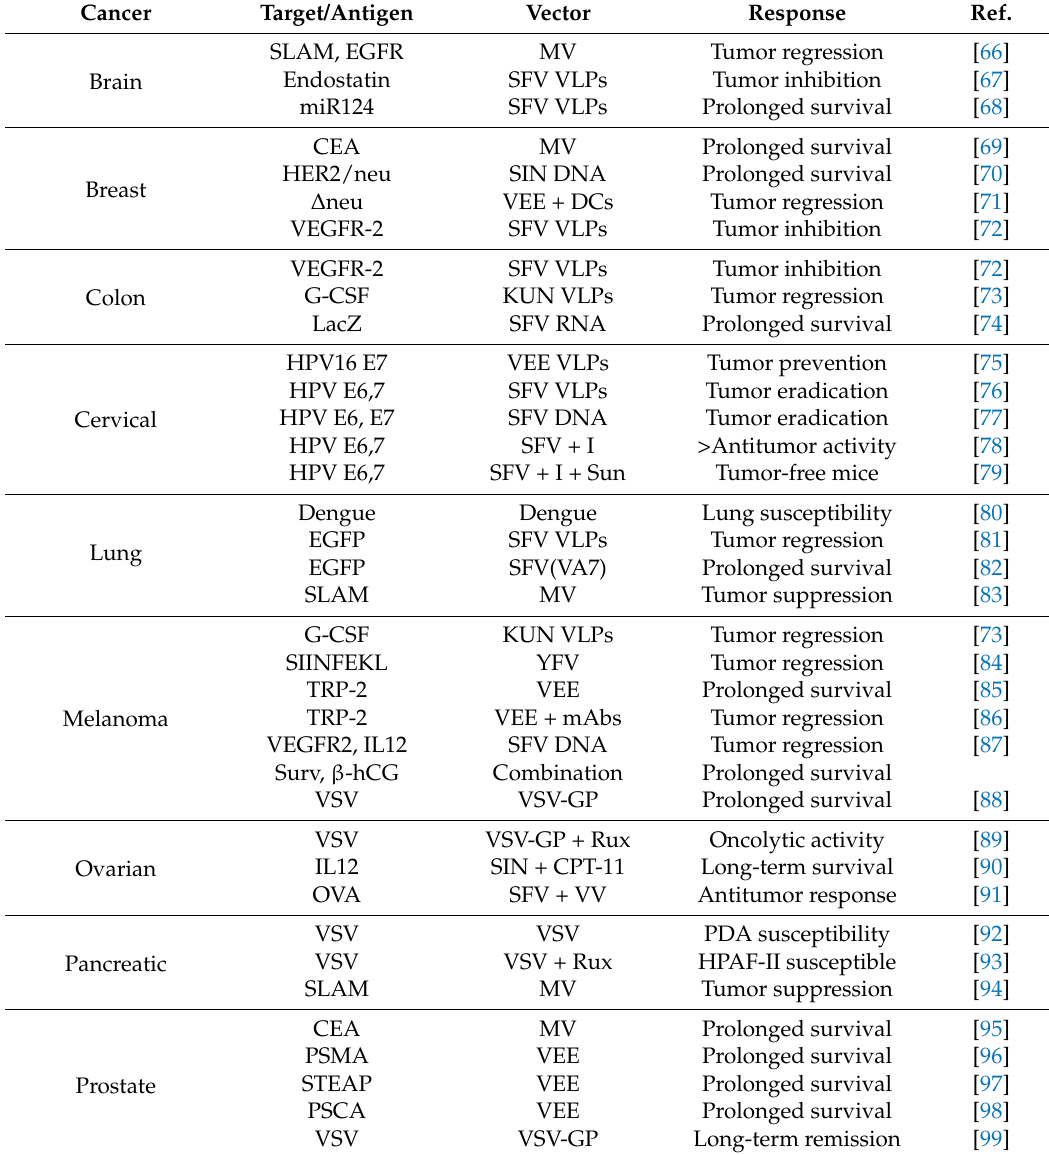
Table 2. Examples of preclinical immunization studies of self-replicating RNA viruses targeting